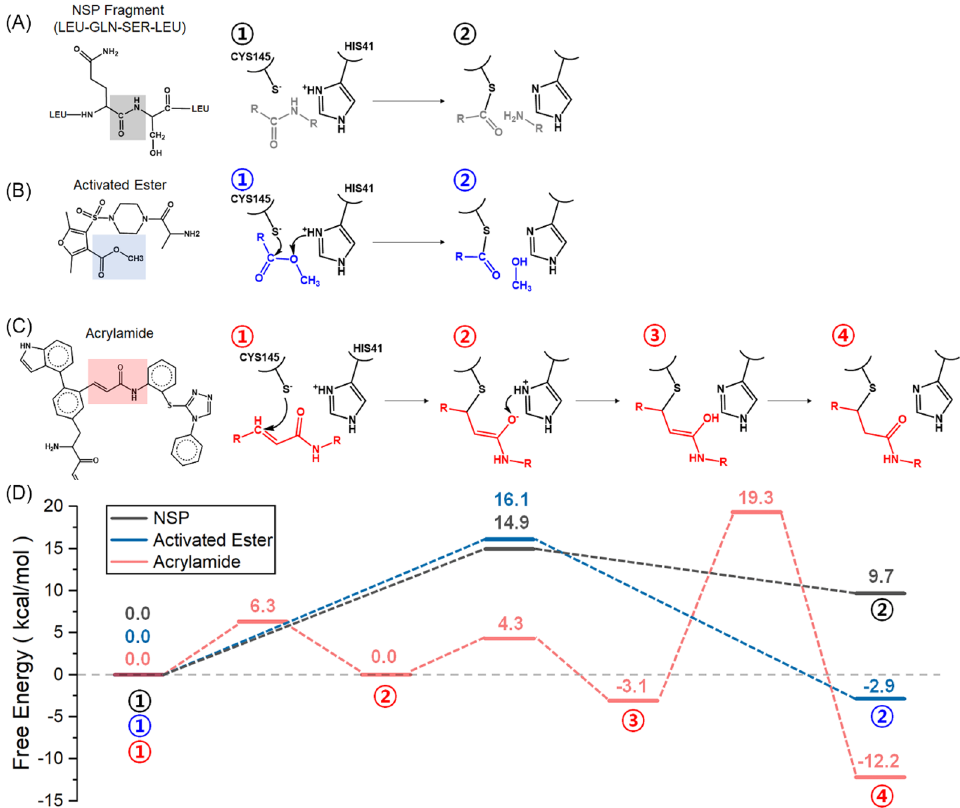
Figure 8. Proposed reaction mechanisms of ( A ) NSP fragment, ( B ) activated ester, and ( C ) acrylamide inhibitor candidates based on the simulations. ( D ) Free energy profiles from the free enzyme with the substrate (E:S state for the NSP) or with the inhibitors (E:I) to the enzyme–substrate (E-S) or enzyme-inhibitor (E-I) complex of three substrates used in this study, which are relative to the energy of E:I state ( ①